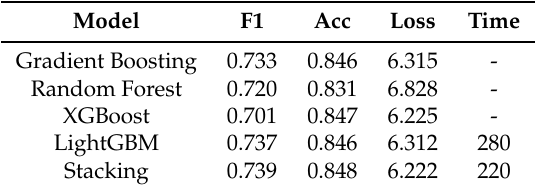
Table 4. Comparison of the classification